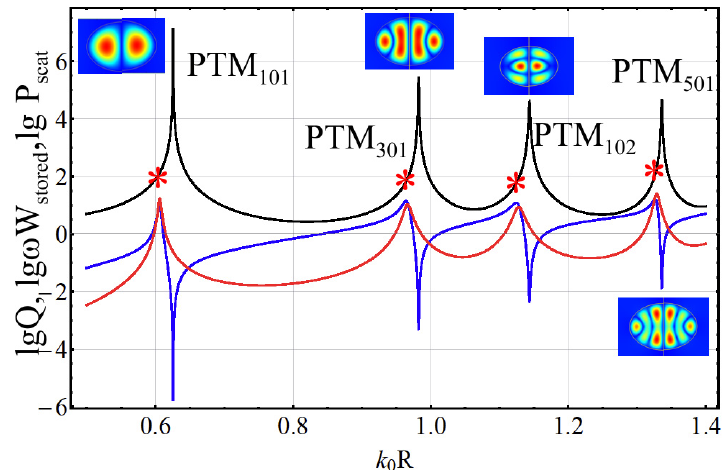
Figure 9. The dependence of logarithms of scattered power P scat (blue), stored energy W stored (red), and radiation quality factor Q = ω W stored / P scat (black) on the size parameter of an oblate spheroid with a/b = 0.7 obtained within the Comsol simulation. TM symmetric excitation (19), α = π /4, ε = 50 (Bi 2 Te 3 ). The insets show the distribution of | H φ | in perfect nonradiating modes. All maxima correspond to perfect nonradiating modes! The red asterisks on the black curve show the Q factor of the usual quasinormal modes.